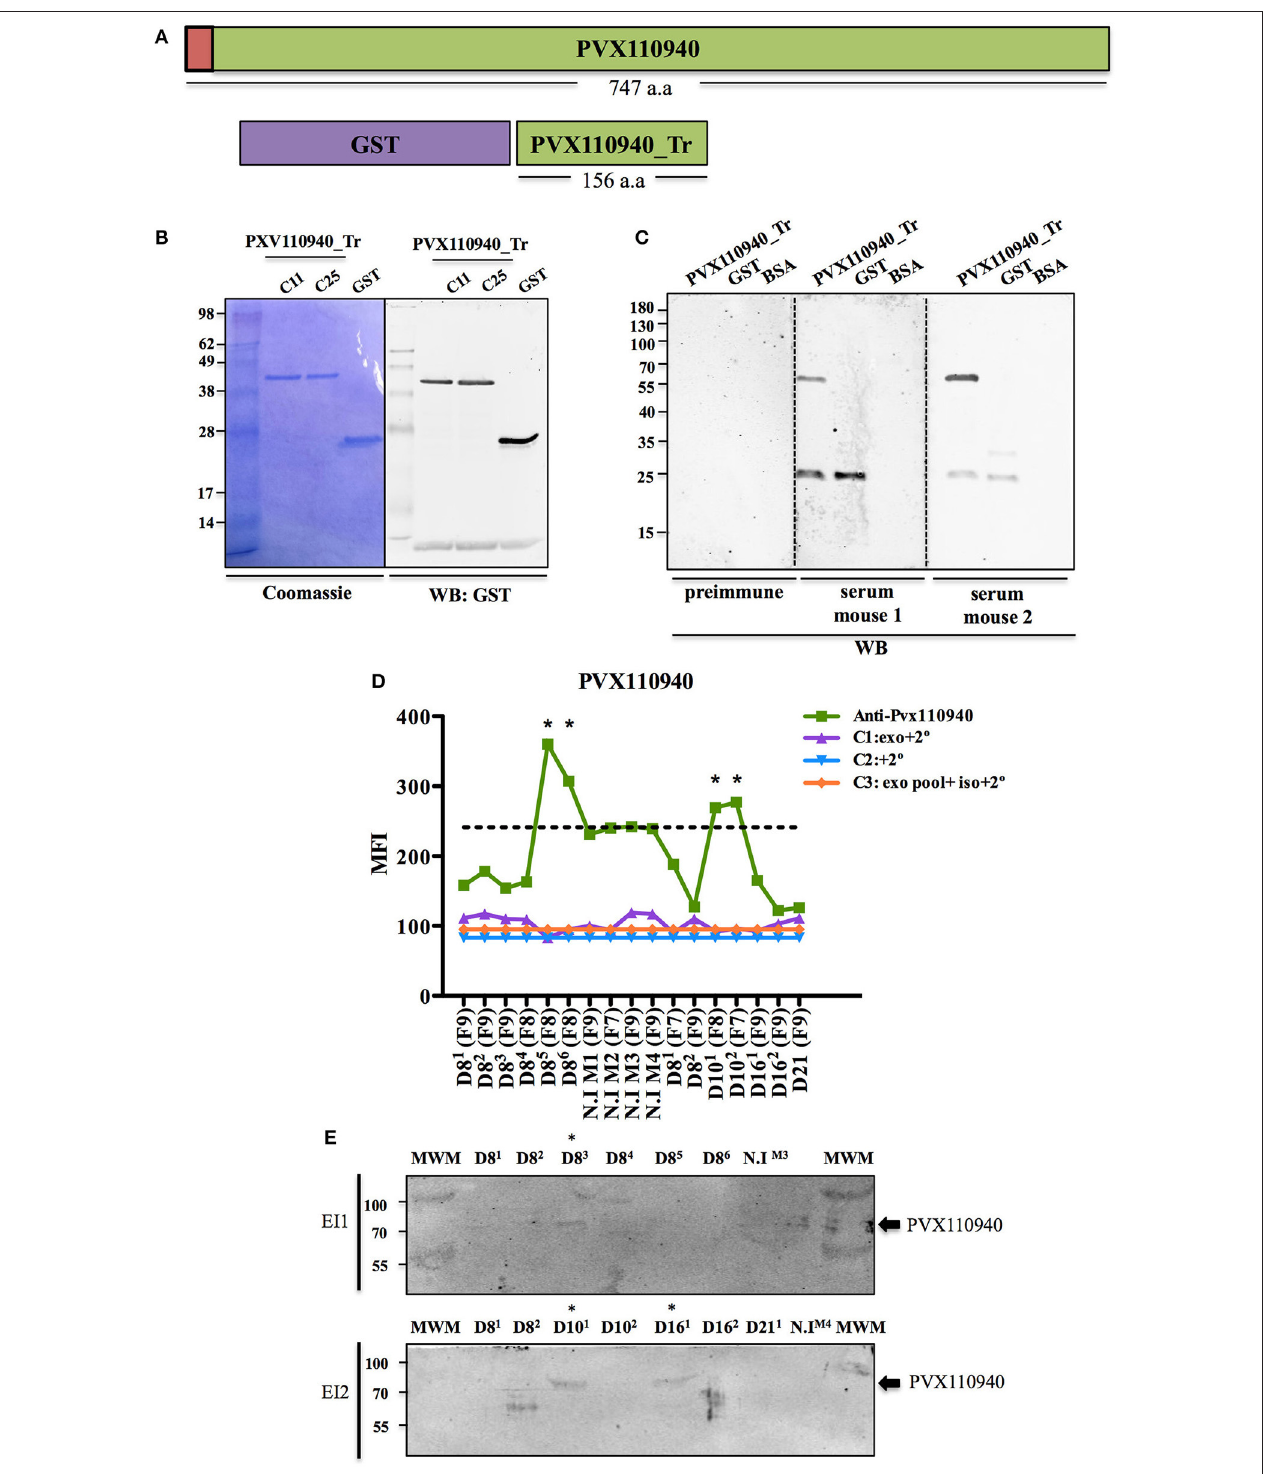
FIGURE 6 | Validation of PVX110940 in plasma-derived exosomes from P. vivax infected FRG huHep mice. (A) Schematic representation of full-length PVX110940 protein and a recombinant GST-fusion truncated (GST-PVX110940-Tr) version containing a predicted B-cell antigenic region of 156 amino acids. Red square represents a predicted N-terminal signal peptide. (B) GST-PV110940-Tr was produced from two E. coli clones (C11 and C25) in a wheat germ cell-free system and